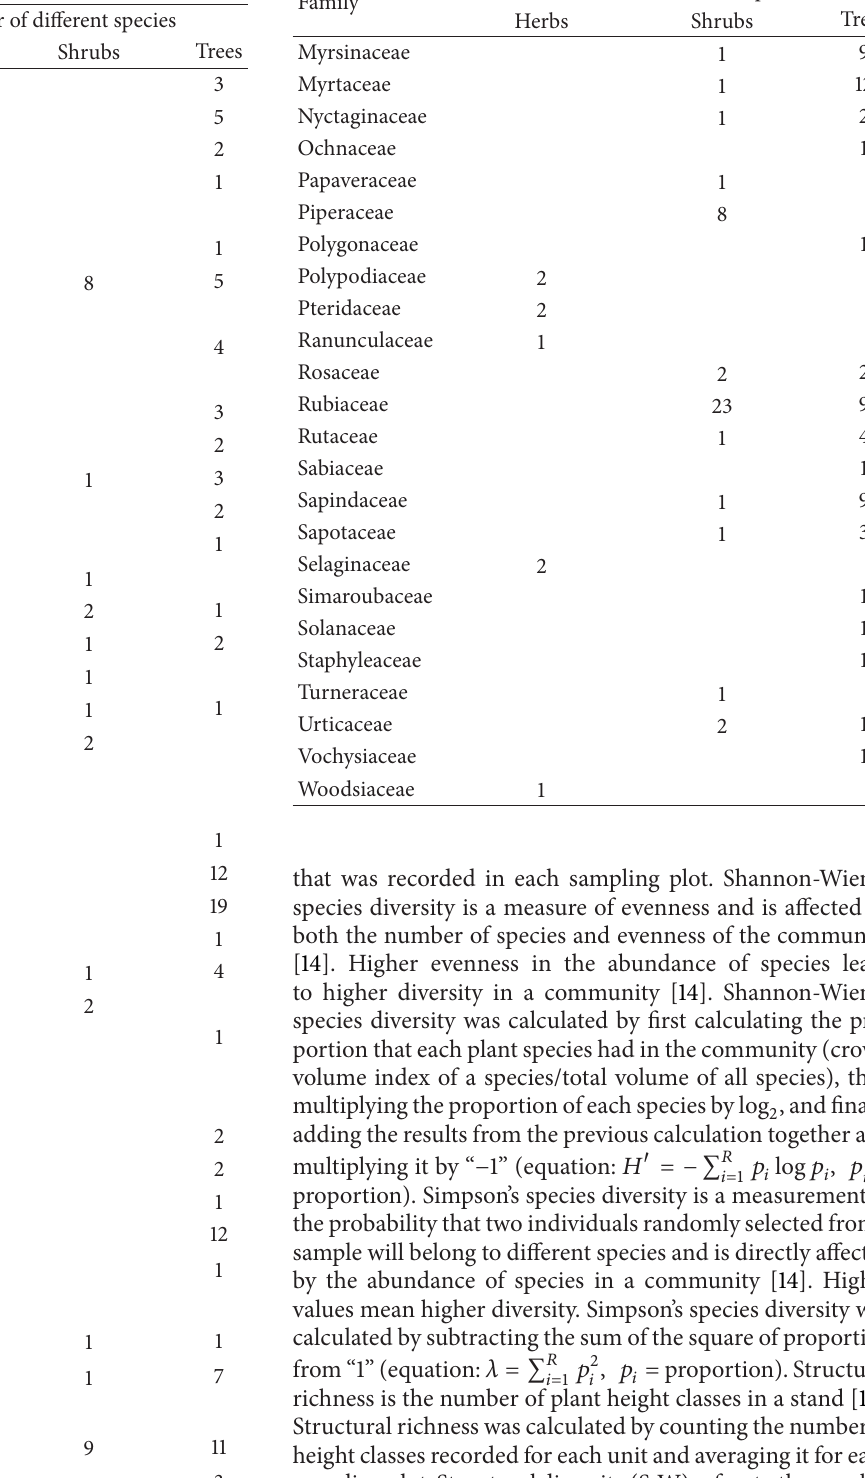
Table 2: Number of species of herbs, shrubs, and trees identified for each family encountered in the